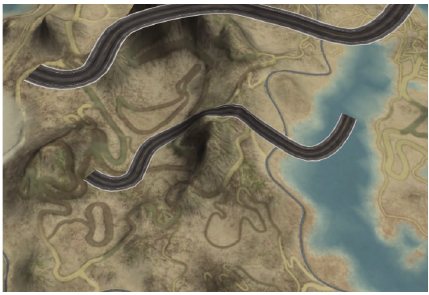
Figure 7: Track over terrain using stenciling.